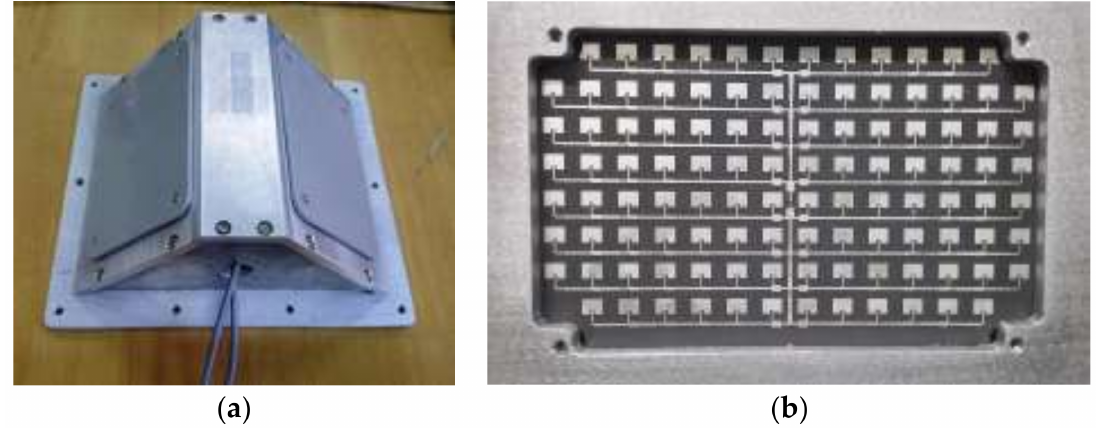
Figure 10. Photographs of the principle prototype of the DDRS: ( a ) the exterior; ( b ) the